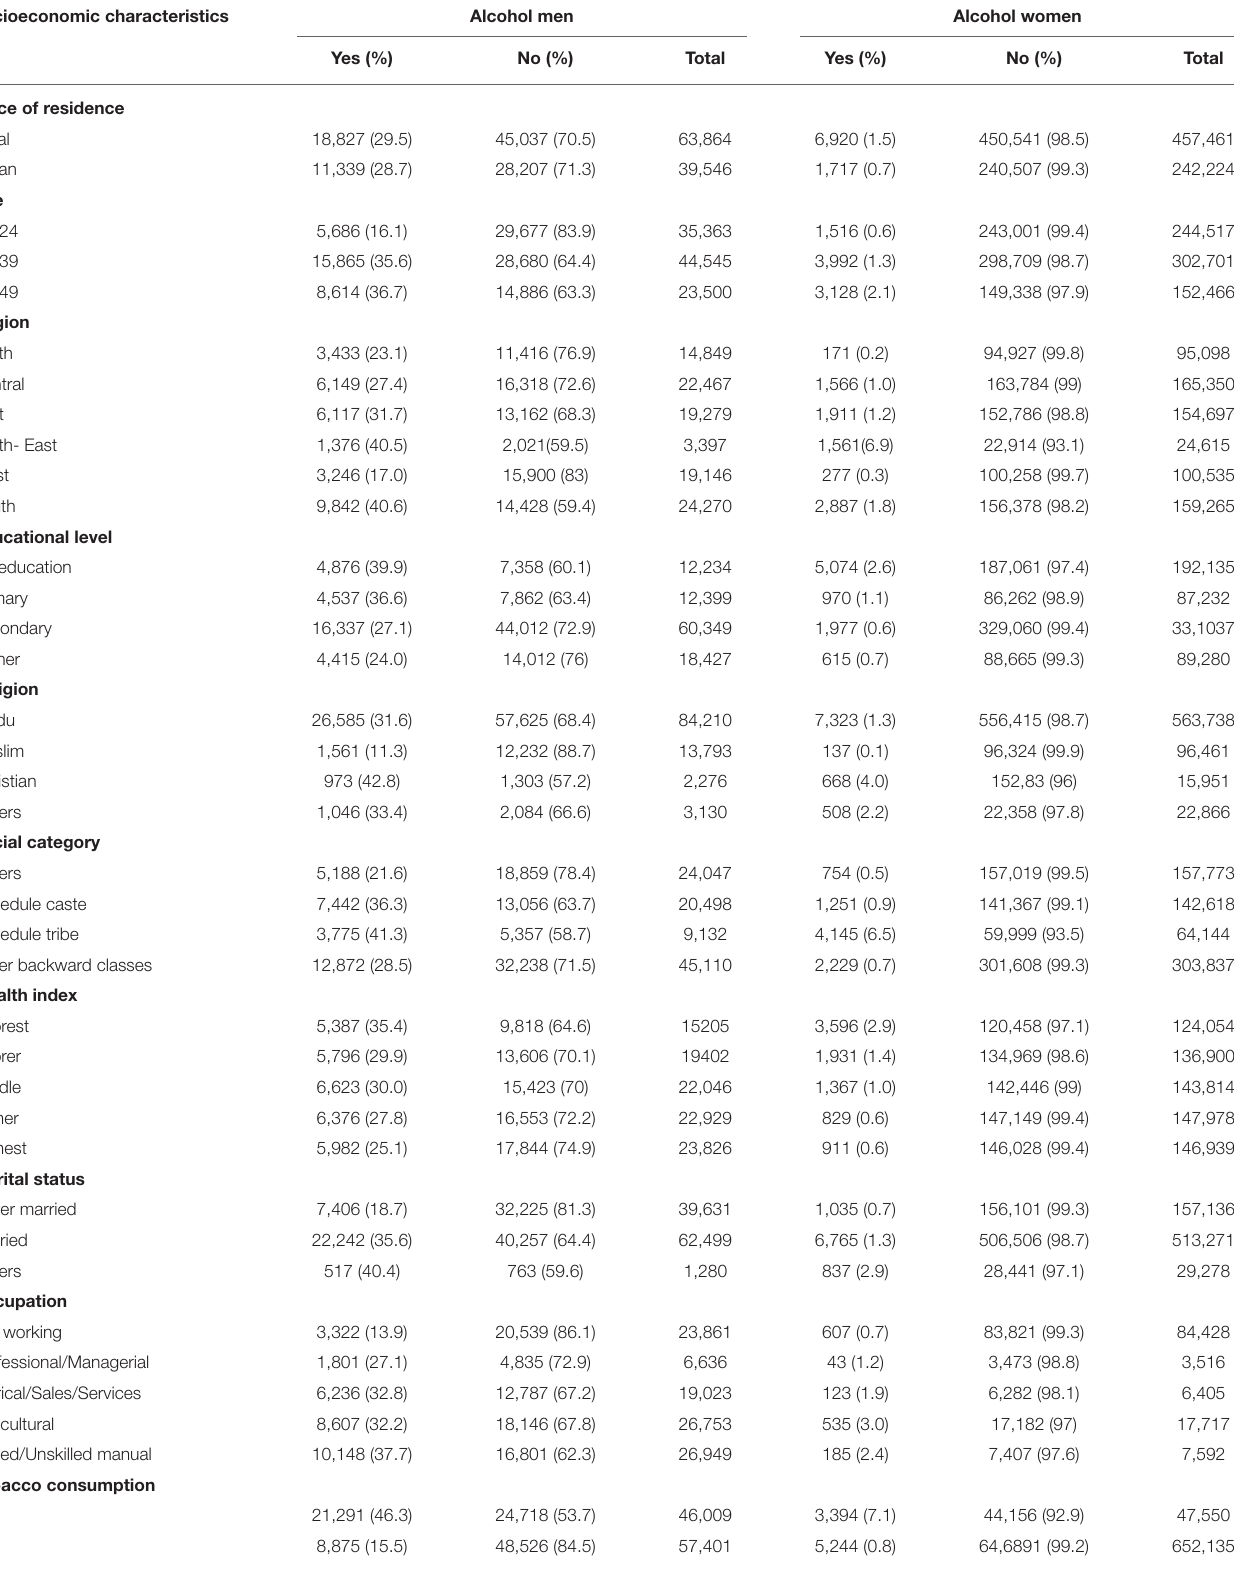
TABLE 2 | Prevalence of alcohol use among survey participants aged 15–49 years by socioeconomic characteristics, India, NFHS-4. Socioeconomic